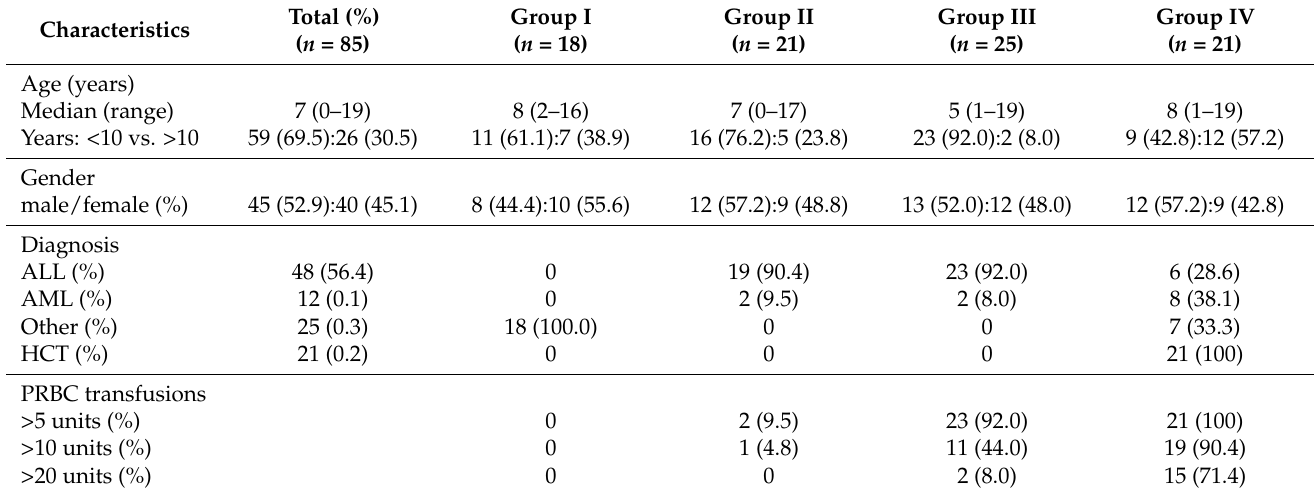
Table 1. Patient